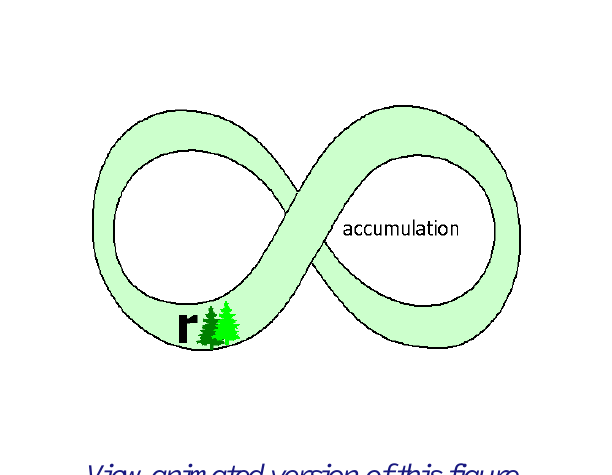
Fig. 2. The adaptive cycle illustrated for a forest ecosystem. Carbon accumulates as the pine forest grows ( r to k ). Carbon and other nutrients are released by fire ( k to W ), and remain largely absent for a short period ( W to a ). At a , a range of propagules enters the system from seed banks and surrounding areas; successional processes ensue, influenced by the abiotic environment; and a pine forest re-establishes itself. In reality, this process will seldom occur for an entire forest, meaning that the "new" forest carries with it elements of the